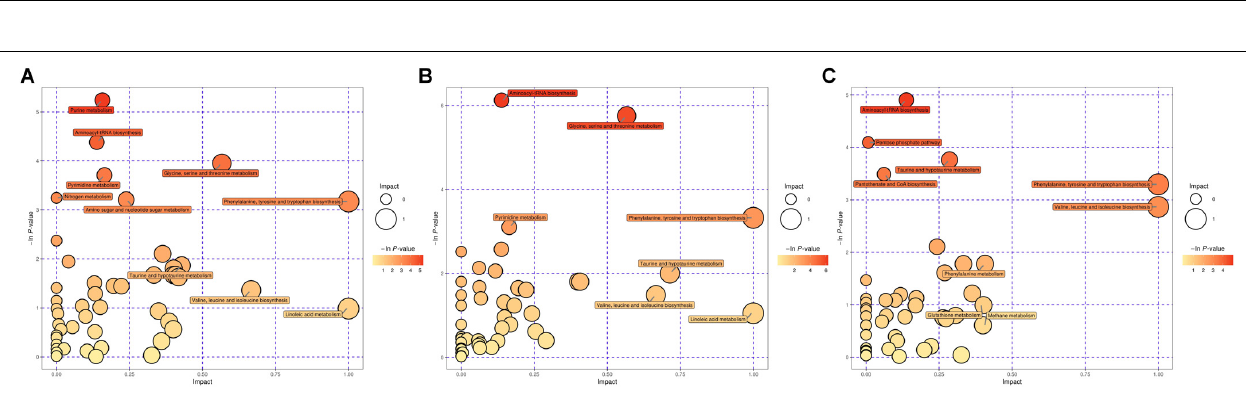
Frontiers in Molecular Biosciences |